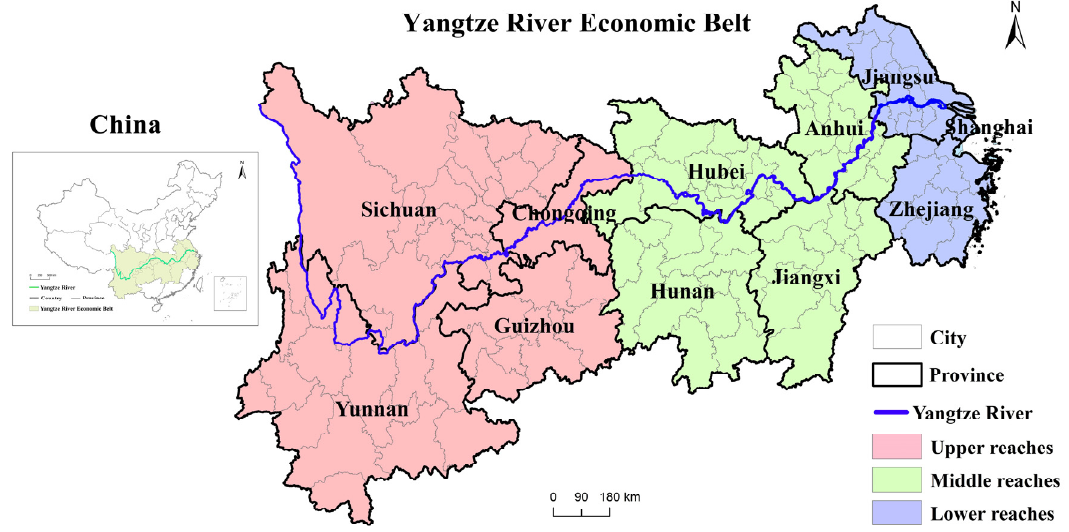
Figure 1. Survey map of the study area.